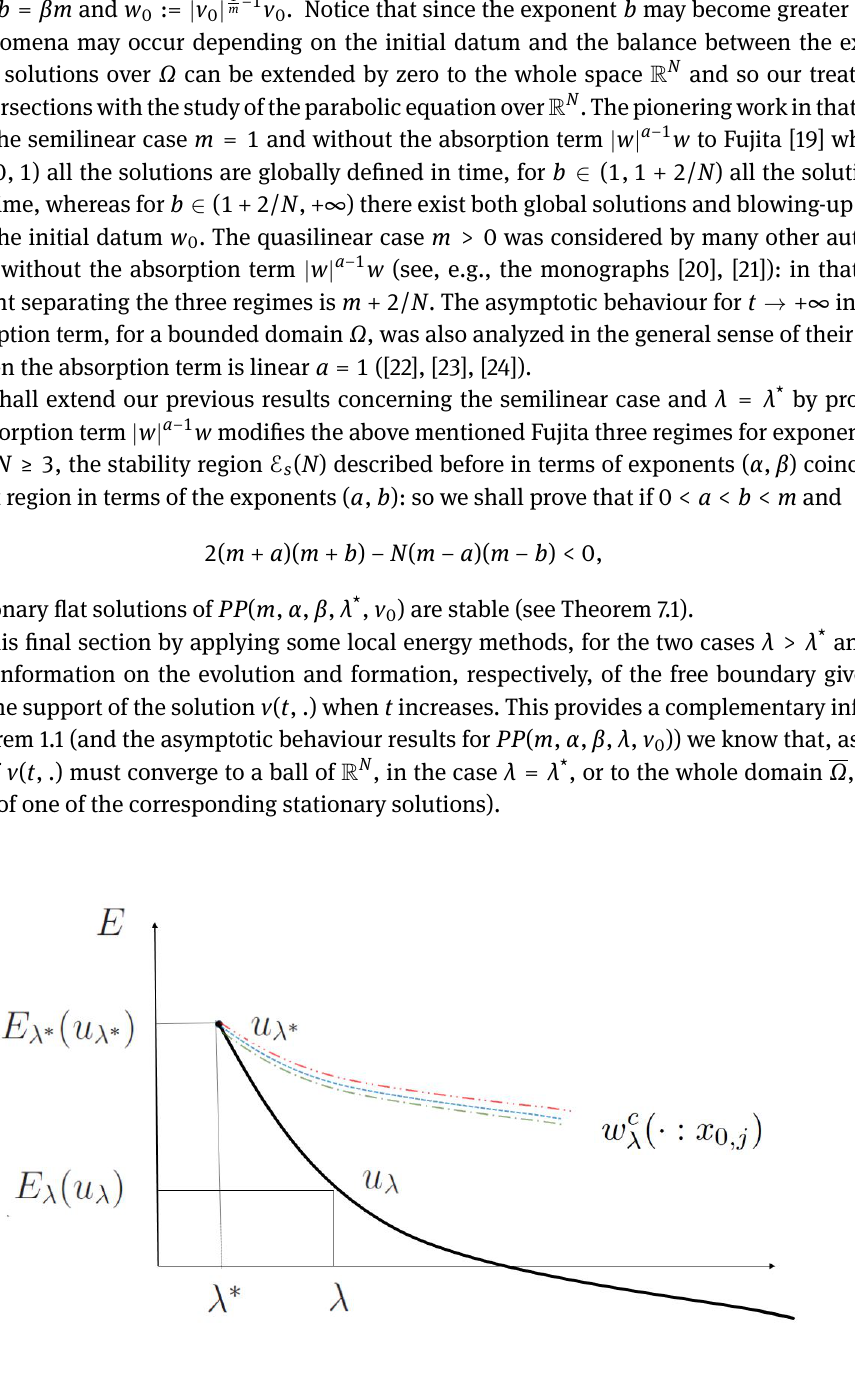
Fig. 3: Bifurcation diagram for the energy levels of ground states and compact support